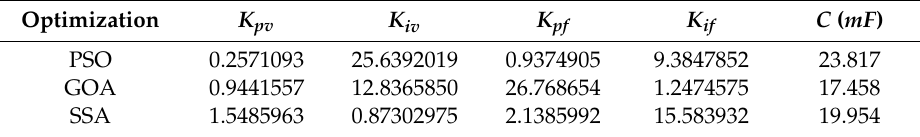
Table 2. The optimized parameters obtained at the end of the